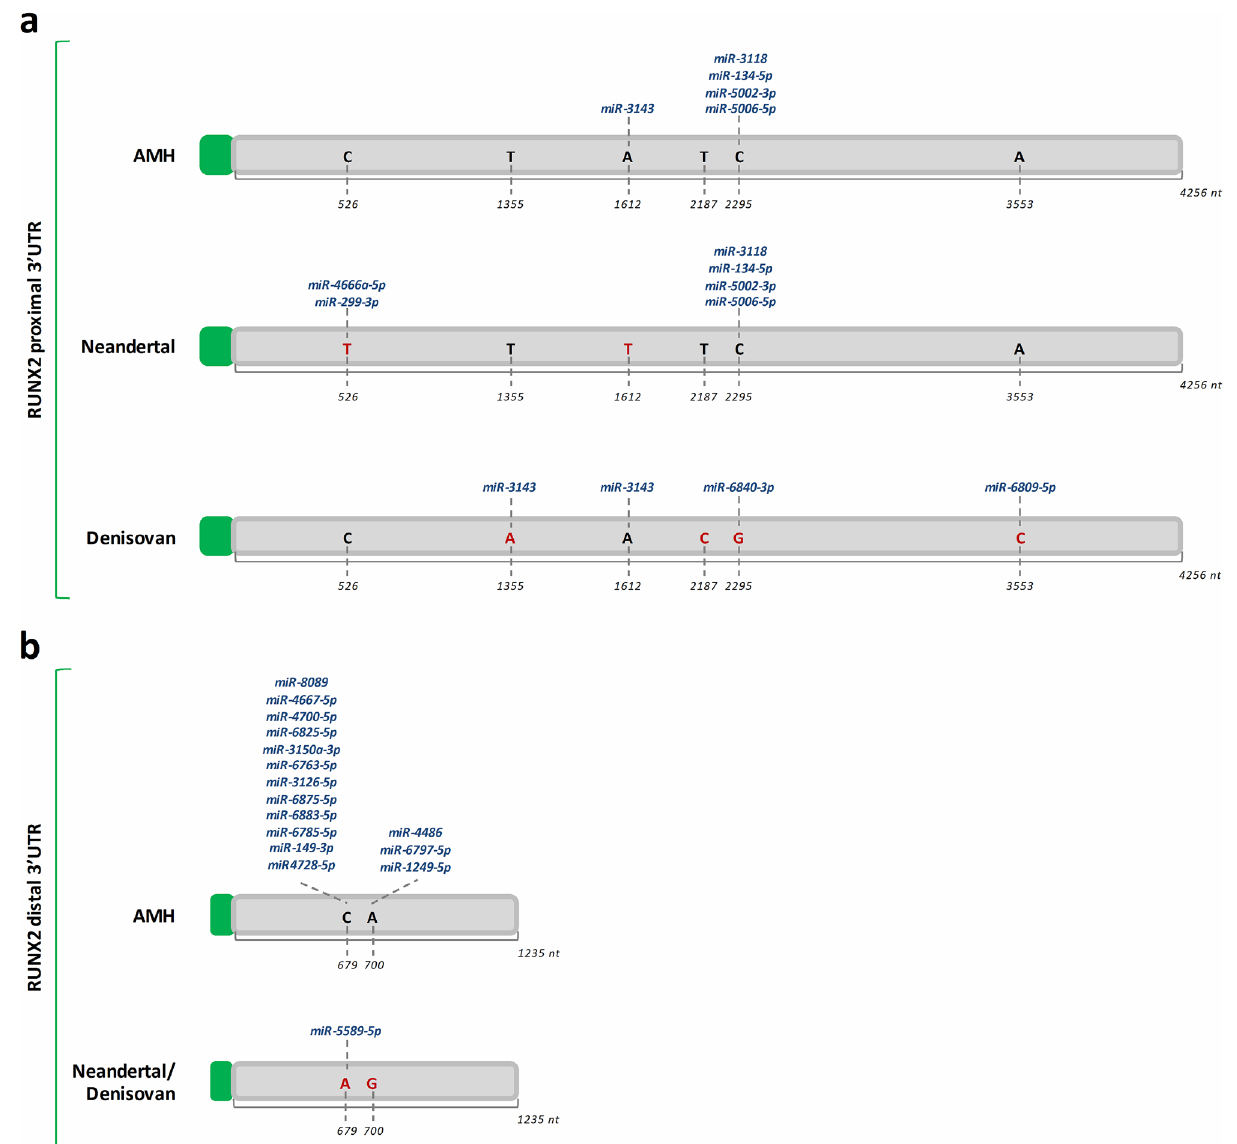
Figure 4. In silico prediction of miRNA binding sites within RUNX2 3’UTRs in AMH, Neandertal and Denisovan. The picture shows the nucleotide changes (highlighted in red) identified in the untranslated regions (UTRs) at the 3’ ends of RUNX2 transcripts in Neandertal and Denisovan hominins compared with that of anatomically modern humans (AMH). The substitutions are apparently able to modify the pattern of miRNA binding both in the proximal 3’UTR (a) and in the distal 3’UTR ( b)